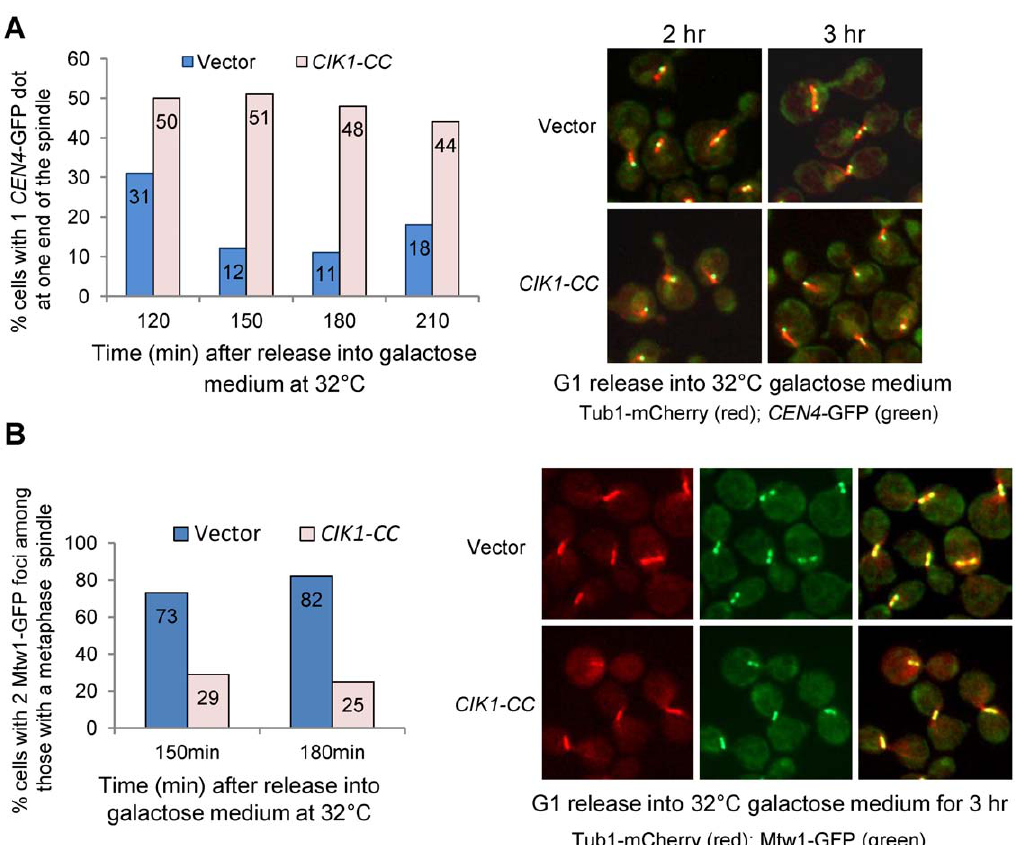
Figure 3. Overexpression of CIK1-CC leads to defects in chromosome bipolar attachment. A. G 1 -arrested cdc13-1 CEN4-GFP TUB1-mCherry cells with a vector or a P GAL CIK1-CC plasmid were released into galactose medium and incubated at 32 u C. Cells were collected at the indicated time points and fixed for the examination of fluorescence signals. The relative localization of CEN4 -GFP in cells with a normal looking metaphase spindle was determined. Of the cells with a metaphase spindle, the percentage of cells with a single GFP dot close to one spindle end was calculated and the result is shown in the left panel (n . 100). The relative localization of CEN4 -GFP signals to the spindle in some representative cells is shown in the right panel. B. cdc13-1 MTW1-GFP TUB1-mCherry cells with a vector or a P GAL CIK1-CC plasmid were released into galactose medium and incubated at 32 u C. Cells were collected at the indicated time points. Among the cells with a metaphase spindle, the percentage of cells with two clear GFP foci was counted and the result is shown in the left panel (n . 100). The spindle morphology and Mtw1-GFP distribution in some representative cells are shown in the right panel.